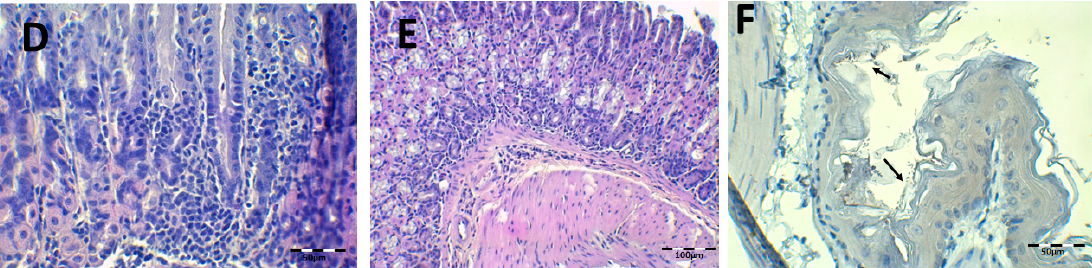
Figure 10. Control Mucolast ® -infected animal microphotographs of the stomach ( A – D ) and esophagus ( E , F ) stained with H-E ( A ), Figure 9. Control, PBS-infected animal microphotographs of the stomach ( A – E ) and esophagus ( F ) stained with H-E Giemsa ( B , arrows indicate H. pylori bacteria), IHC ( C , F , arrows indicate H. pylori bacteria), and PAS ( D ). ( A , D , E ), Giemsa ( B , arrows indicate H. pylori bacteria), and IHC ( C , F , arrows indicate H. pylori bacteria).